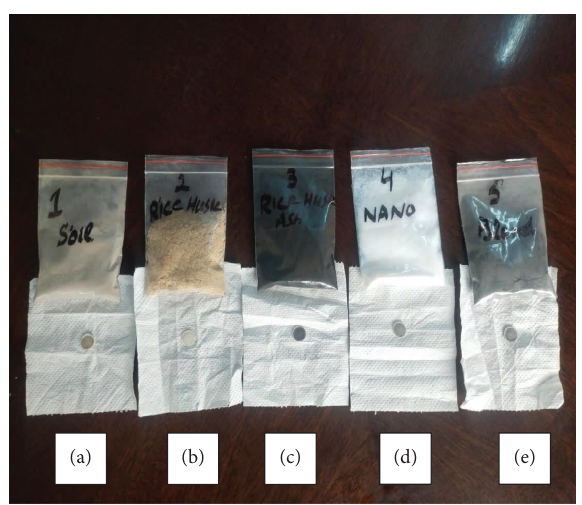
Figure 3: Palettes for the FTIR tests, i.e., (a) soil, (b) rice husk, (c) rice husk ash, (d) nanosilica, and (e) optimum blend of (a), (c), & (d).